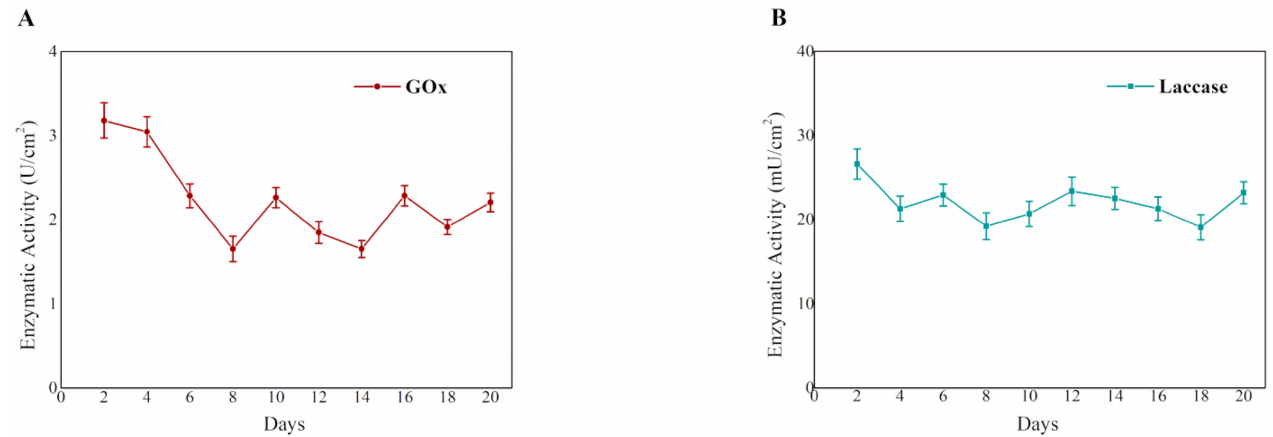
Figure 4. Trend of enzyme activity of GOx ( A ) and Laccase ( B ) immobilized on PV15 films as a function of